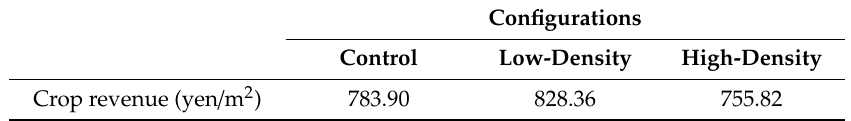
Table 7. Annual revenue per square meter from corn crops grown in di ff erent